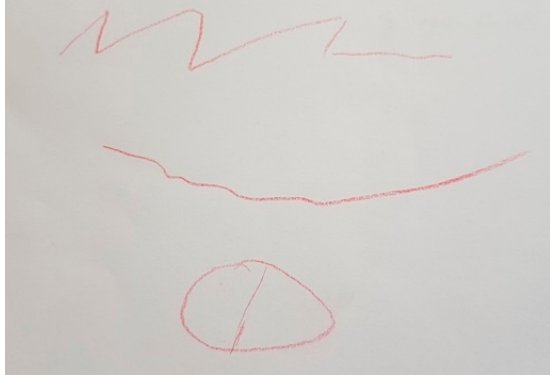
Figure 1. P28’s perception of PD.